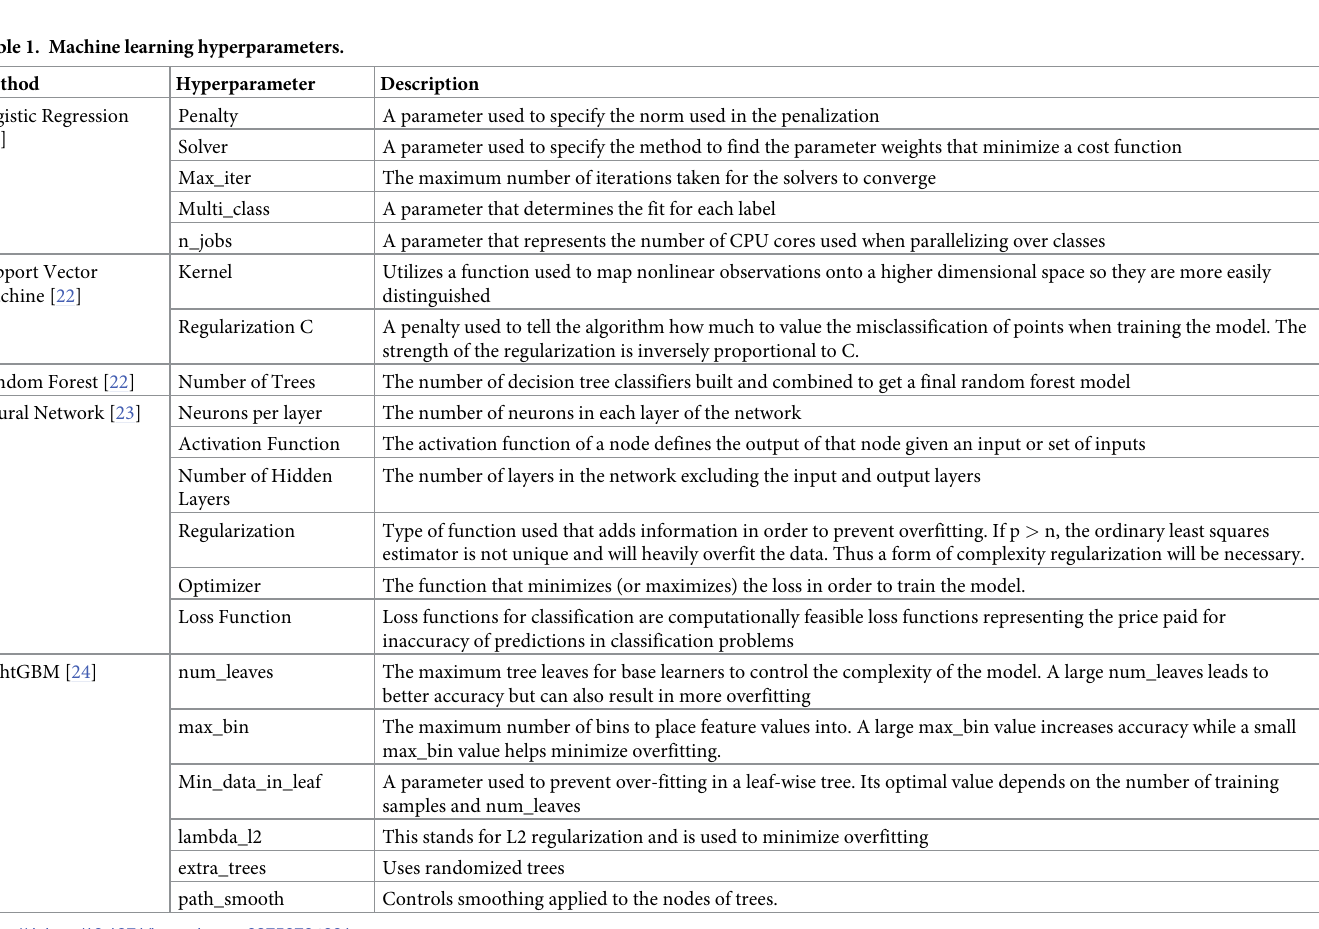
Table 1. Machine learning